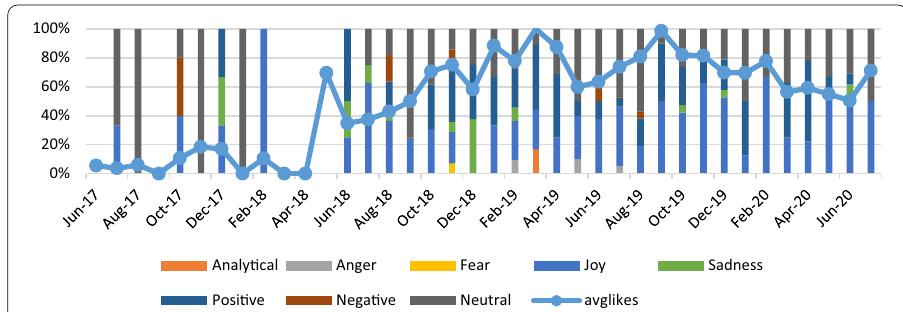
Fig. 15 Relation between the sentiments and the average number of likes (normalized) over